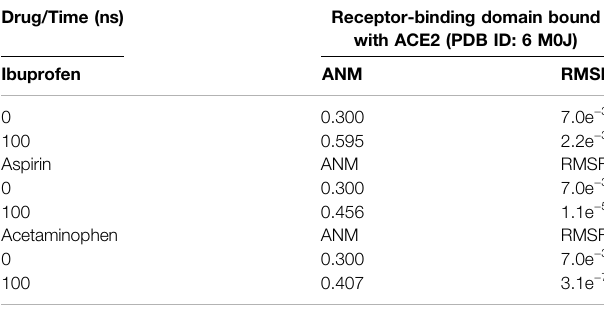
TABLE10| DynamiccharacteristicsoftheRBD-ACE2complexinthepresenceof NSAIDs at 100 ns. Drug/Time